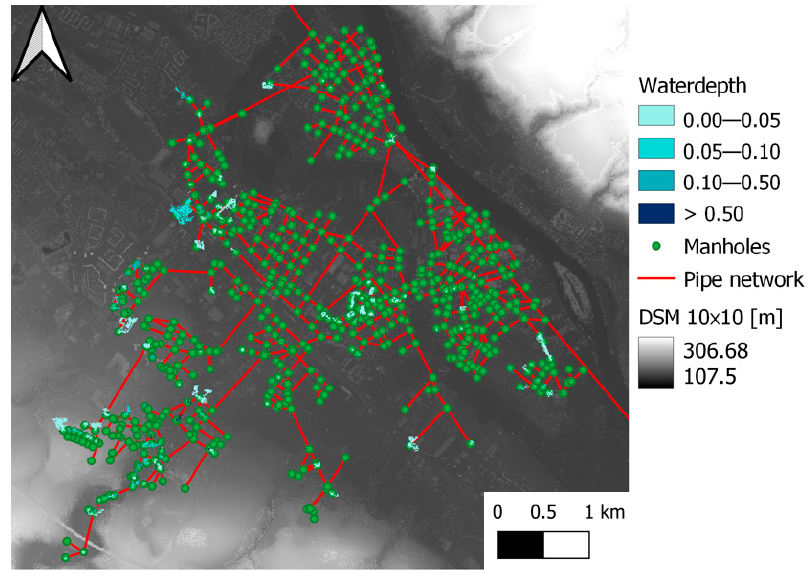
Figure 5. Total flood inundation extents and depths for a design storm event with a 100-year return period.